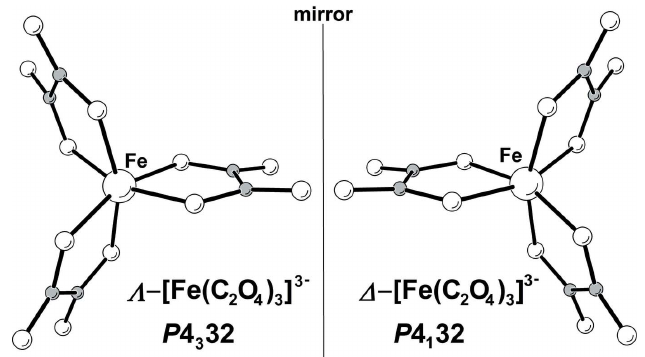
Figure 2 Views of the (cid:2) and (cid:3) enantiomers of [Fe(C 2 O 4 ) 3 ] 3 (cid:2)